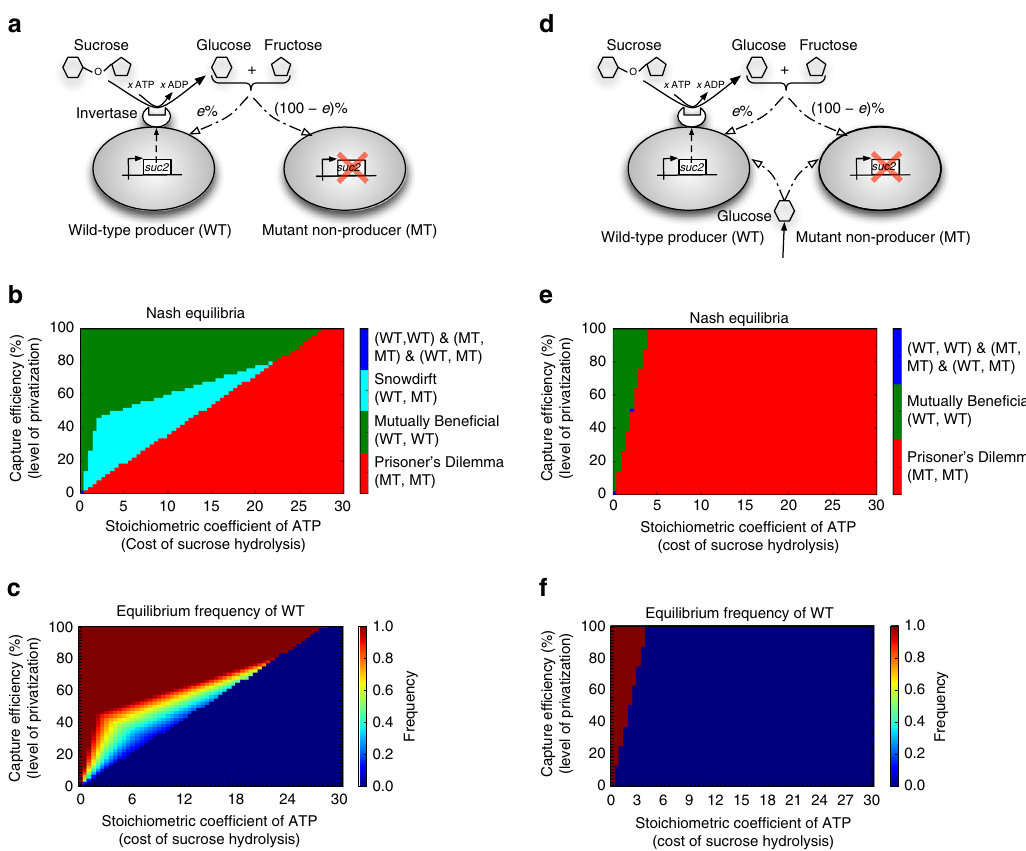
Fig. 2 Metabolic dependencies in populations of S. cerevisiae growing on sucrose. a Metabolic interactions between producer (wild-type, WT) and non- producer (mutant, MT) genotypes of S . cerevisiae growing on sucrose 34 . Here, e represents the percentage of glucose/fructose that diffuses away and serves as a public good. b Nash equilibria and c the equilibrium frequency of WT for the community shown in a as a function of the capture ef fi ciency of the glucose/fructose and the invertase production cost (that latter was implicitly modeled by changing the stoichiometric coef fi cient of ATP in the sucrose hydrolysis reaction, indicated by x ). An alternative in silico formulation of the energetic cost of invertase production that reproduces exactly the setup used in the experiment by Gore et al. 34 (based on histidine auxotrophy) proved to be qualitatively equivalent to the analysis presented here (see Supplementary Note 2 for details). The equilibrium frequency of WT in c was obtained from in silico invasion experiments (see “ Methods ” ) for two cases of a small fraction of MT invading a resident population of WT and vice versa. This analysis demonstrated that the equilibrium frequency of WT is the same in both cases (results are shown here for only one case). d Metabolic interactions between WT and MT when additional glucose is provided in the growth medium (see Supplementary Methods for details of implementation). e Nash equilibria and f the equilibrium frequency of WT in the presence of glucose in the growth medium. The entire Snowdrift game region and part of the Mutually Bene fi cial region in b are replaced by the Prisoner ’ s Dilemma game, in e , which is consistent with previous reports 34 and serves as an additional veri fi cation of our modeling approach. This is because in the presence of an external supply of glucose, MT is less dependent on WT, leading to an increase in the average fi tness of biosynthesis pathways (genes) for an amino acid, respectively. In a community composed of all these four genotypes, different types of interactions are possible. Here we focus on pairwise interactions, such as cross-feeding, [01, 10], and unidirectional dependency, [00, 11], though higher-order interactions among three or four genotypes (e.g., [00, 01, 10] and [00, 01, 10, 11]) are